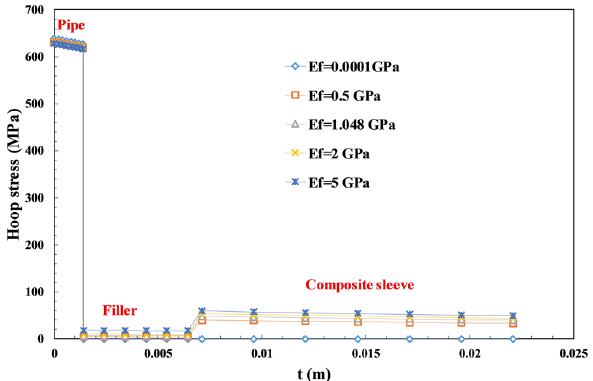
Fig. 22 Effect of partially bond factor considering the effect of filler